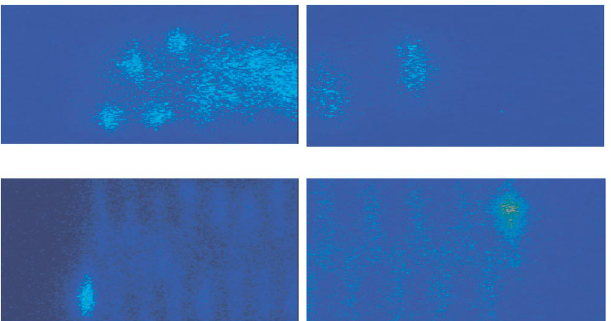
FIG. 31. (Color) Streak-camera measurement in dual-sweep mode of individual vertical beam sizes and their y - z correlation at BEPC [38]; bunches in the head (left) and tail of the train (right) are compared without (top) and with (cid:6) 600 V bias at all 128 BPM buttons (bottom); the vertical axis is the time along the bunch, the horizontal axis the vertical direction; consecutive bunches are displayed, separated horizontally.